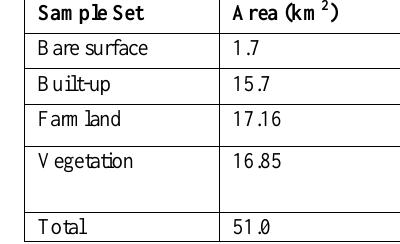
Figure 6b- Land use/Land cover map of study area for 2012